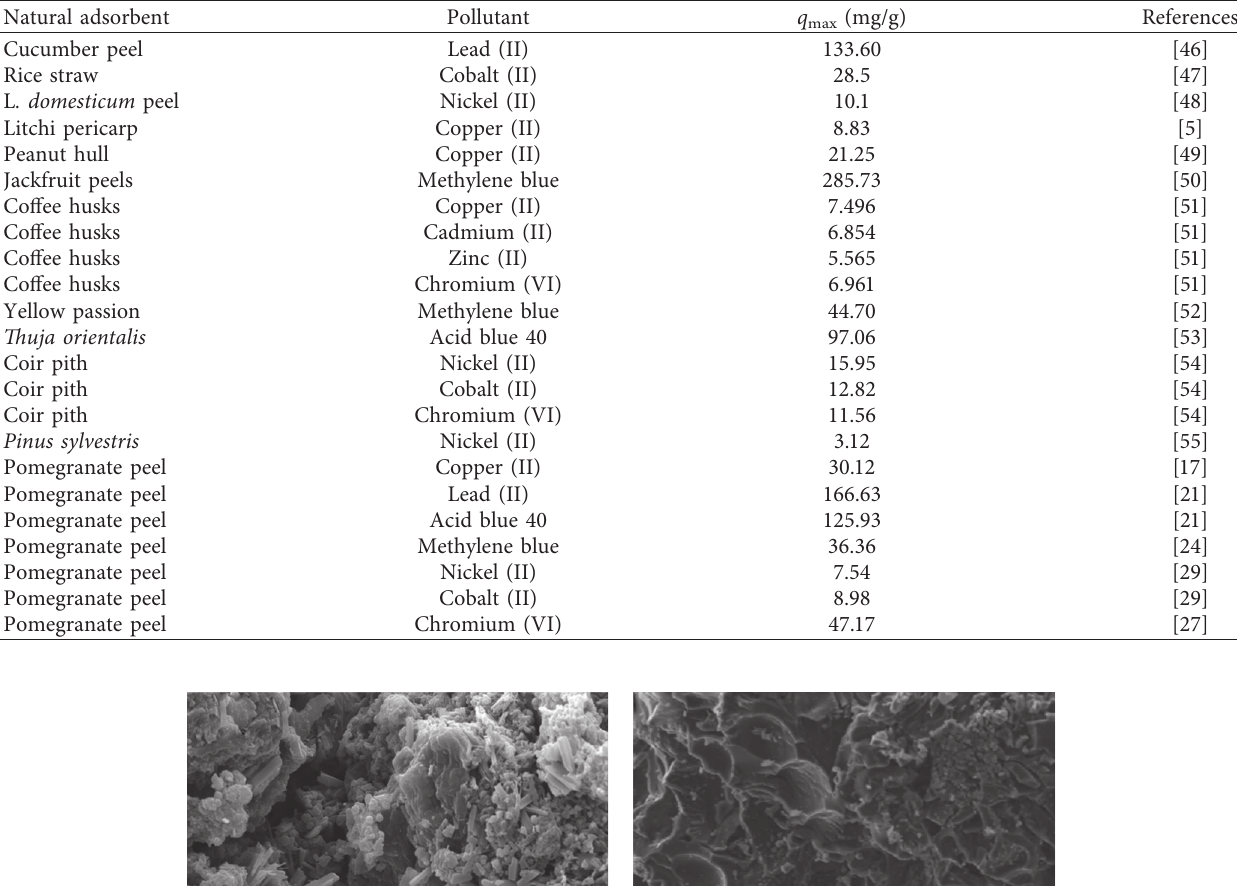
Table 4: Langmuir constants q max (mg/g) of various untreated waste adsorbents for pollutant removal.